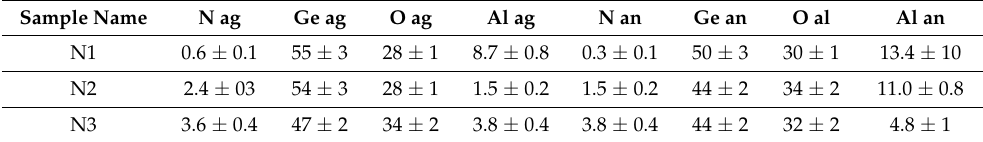
Table 3. The atomic composition of the films was measured by TOF-ERDA. The values for the as-grown films are denoted by ‘ag’ and for the annealed films by ‘an’. All values are given in atomic percentages (at